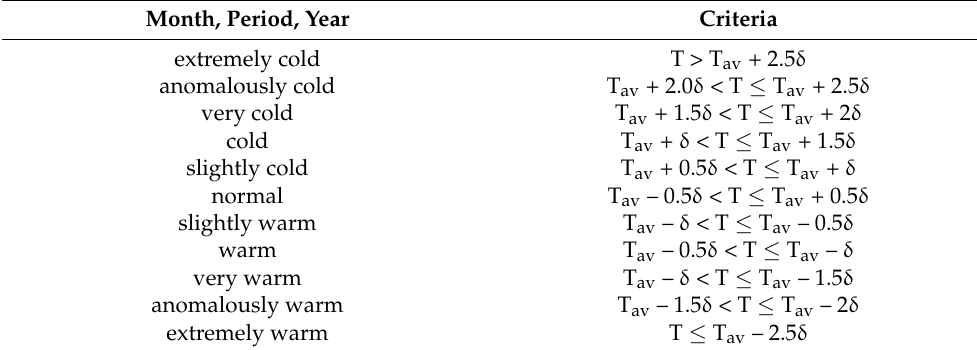
Table 1. Thermal classification of months, seasons and